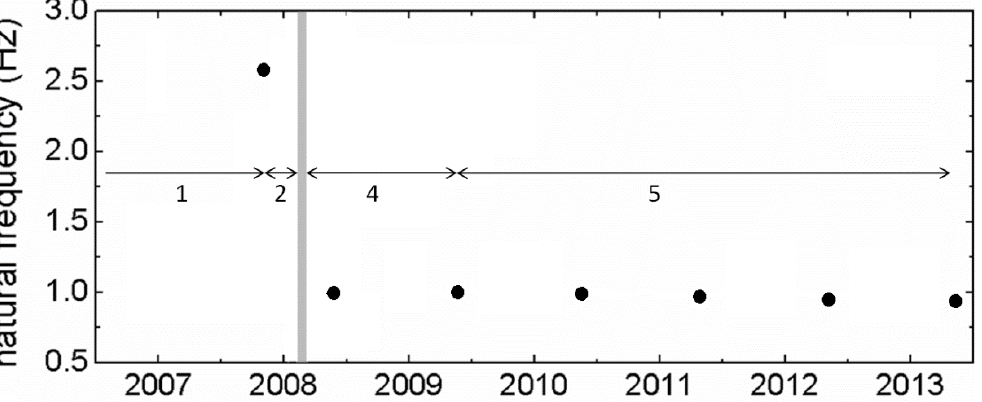
Figure 2. Changes of the first lateral modal frequency and damage stages discussed below. Based on [2,3]. Damage stage intervals are marked with arrows and numbers, stage 3 (icing event) is indicated by a gray line (not in scale).